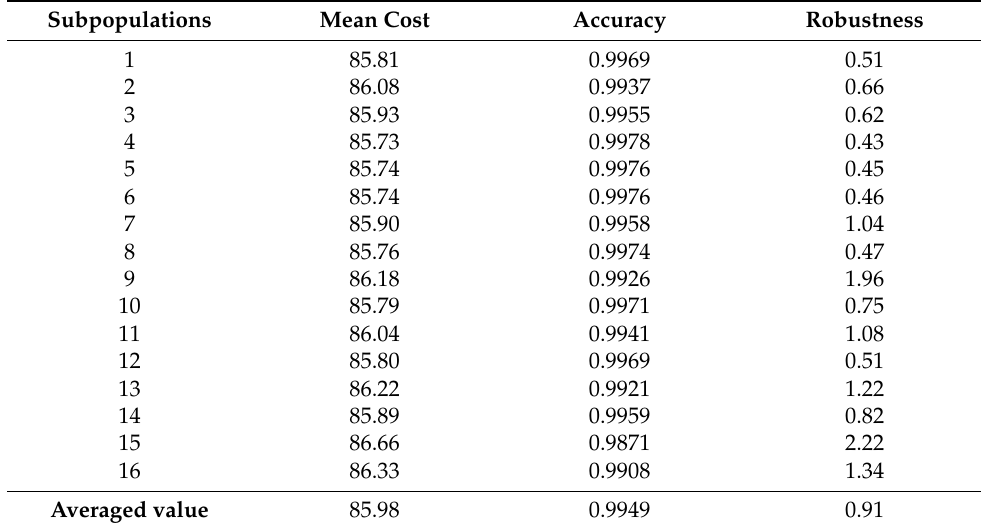
Table 3. Cross-section under flexure. Global, small, random displacement (GSRD). Performance metrics.